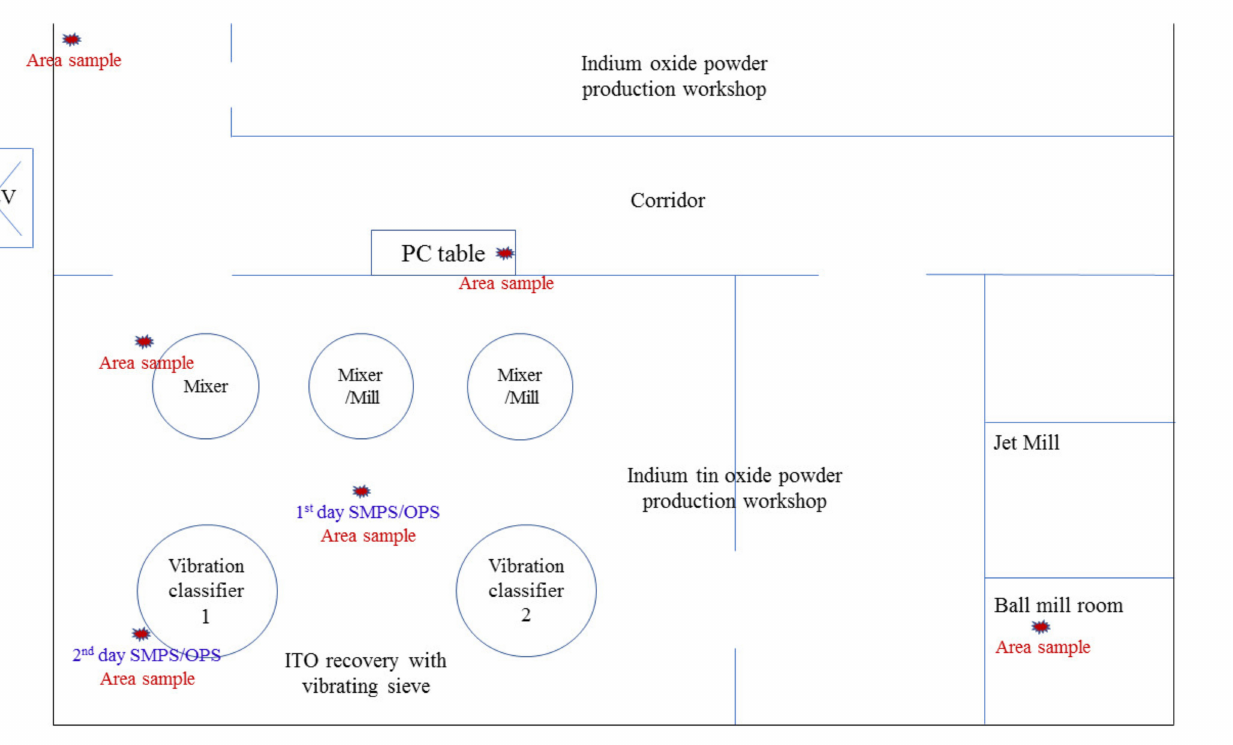
Figure 1. Facility layout of the indium tin oxide powder production workshop. (cid:73) indicates area sample measurement